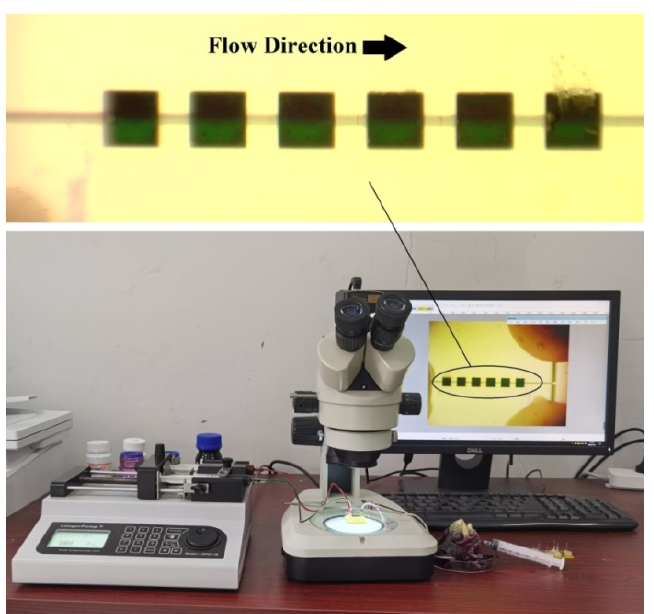
Figure 9. Visual test system and microscopic images of the mixer with junctions at Location 5.